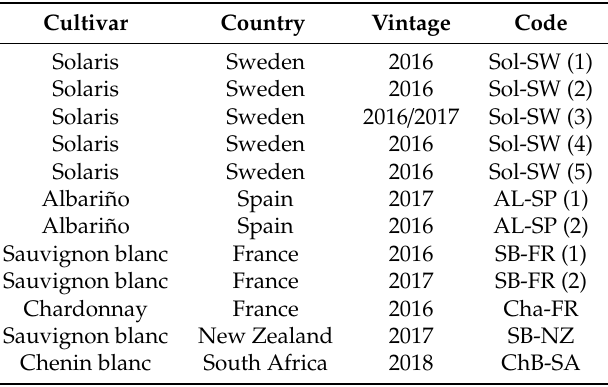
Table 1. Wines used for the study. Country Vintage